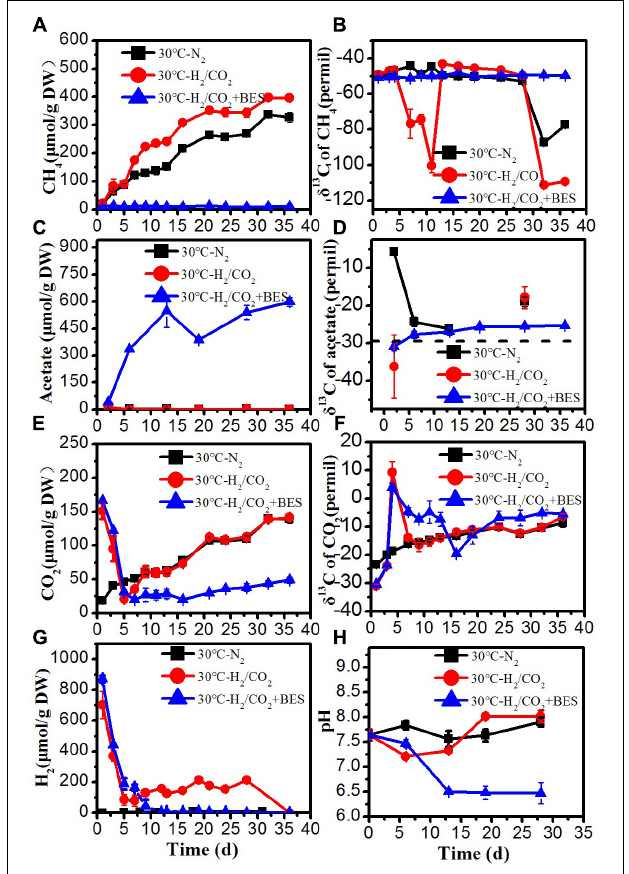
FIGURE 1 | Time course of accumulated (A) CH 4 , (B) δ 13 C of CH 4 , (C) acetate, (D) δ 13 C of acetate, (E) CO 2 , (F) δ 13 C of CO 2 , (G) H 2 concentration, and (H) pH during the treatment of sewage sludge at 15 ◦ C, BES as an inhibiter of methanogenesis. The δ 13 C of the sludge organic matter